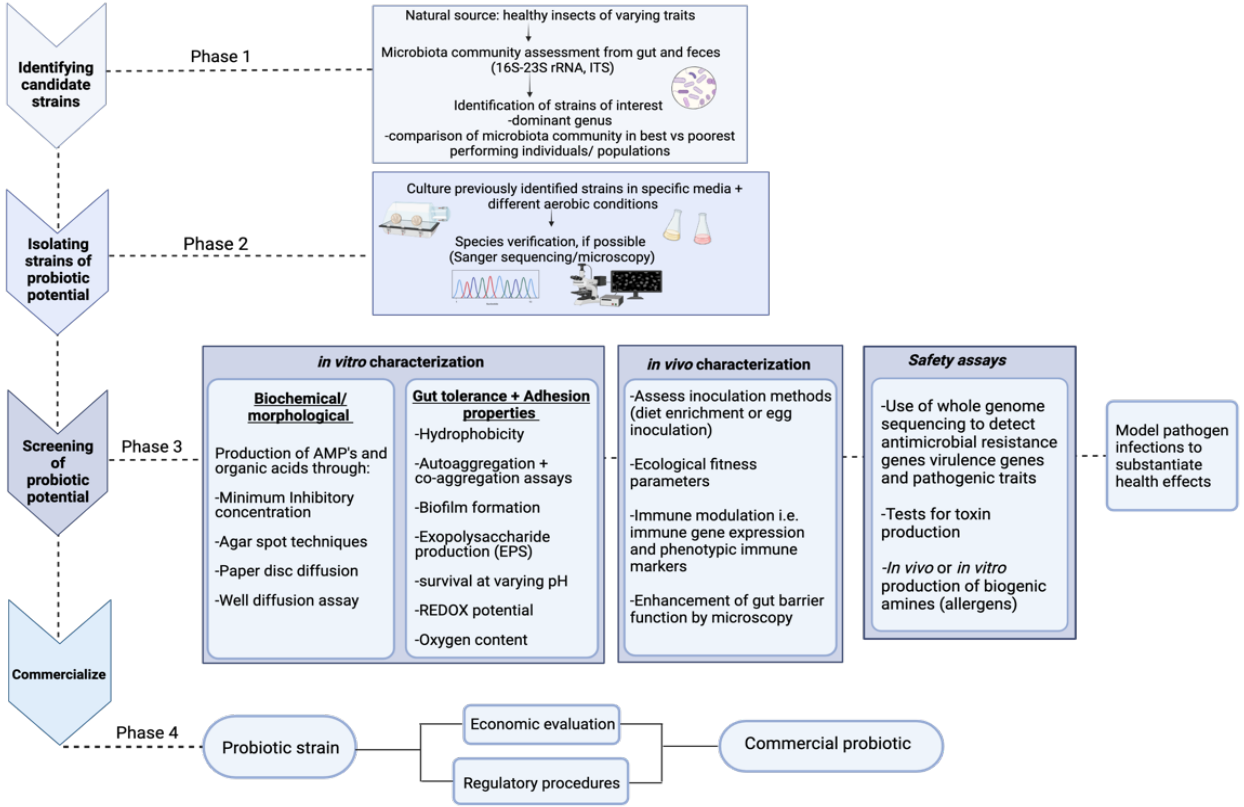
Figure 1. General workflow and screening techniques to characterize strains probiotic potential prior to commercialization. Phases 1 and 2 display the identification of candidate strains and isolation methods; phase 3 offers different in vitro and in vivo techniques for characterizing the probiotic potential. Fundamental in vitro safety assays are also listed. Phase 4 highlights two major factors that also need evaluation prior to the probiotic being used